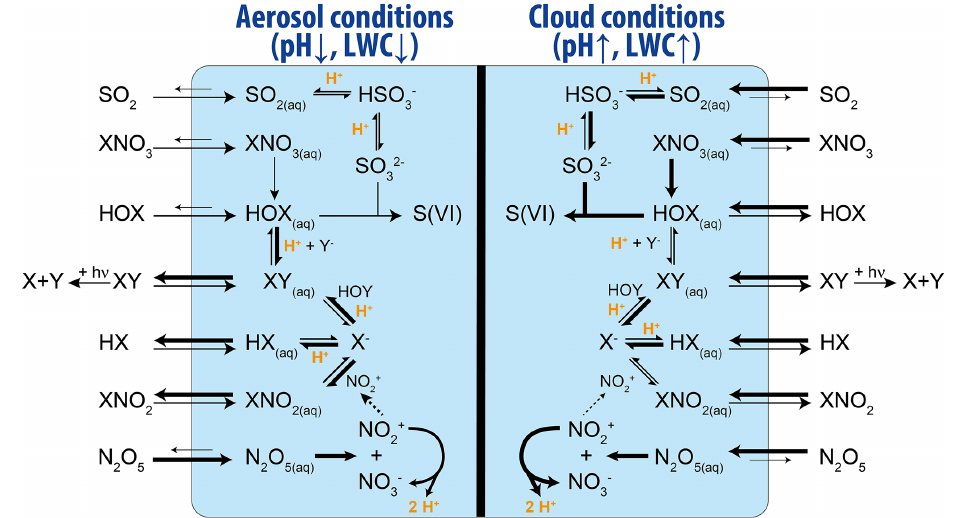
Figure 8. Simplified scheme of the reactive halogen chemistry and their differences between diluted less acidic cloud conditions and more concentrated and acidic aerosol conditions. Differences in the chemical rates and uptake fluxes are indicated by thinner and thicker arrows,